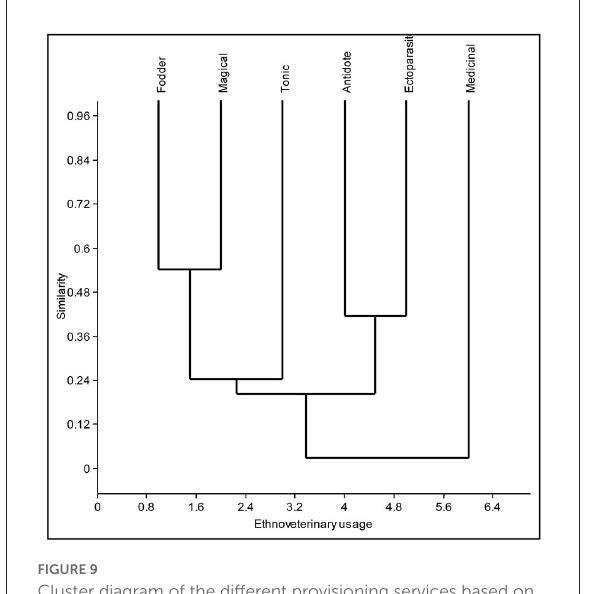
FIGURE11 Correlogram showing the Pearson correlation results between ethical groups evaluated in the 3 regions.